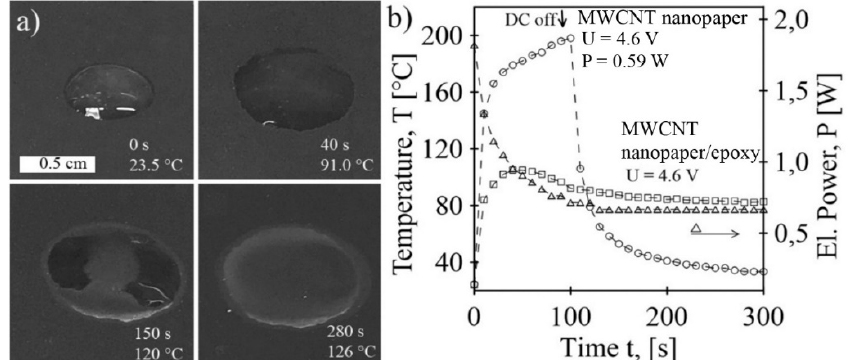
Figure 2. ( a ) Time-dependent curing of the epoxy resin droplet on the surface of the entangled MWCNT nanopaper by Joule heating at constant DC voltage. Respective times of curing and corresponding temperatures are indicated in the figure. ( b ) Temperature progression in the course of MWCNT nanopaper/epoxy curing by Joule heating at DC voltage 4.6 V is denoted by squares, the corresponding time dependence of the electrical power by triangles, and the time-dependence of the temperature during the MWCNT nanopaper heating at DC voltage of 4.6 V by circles.